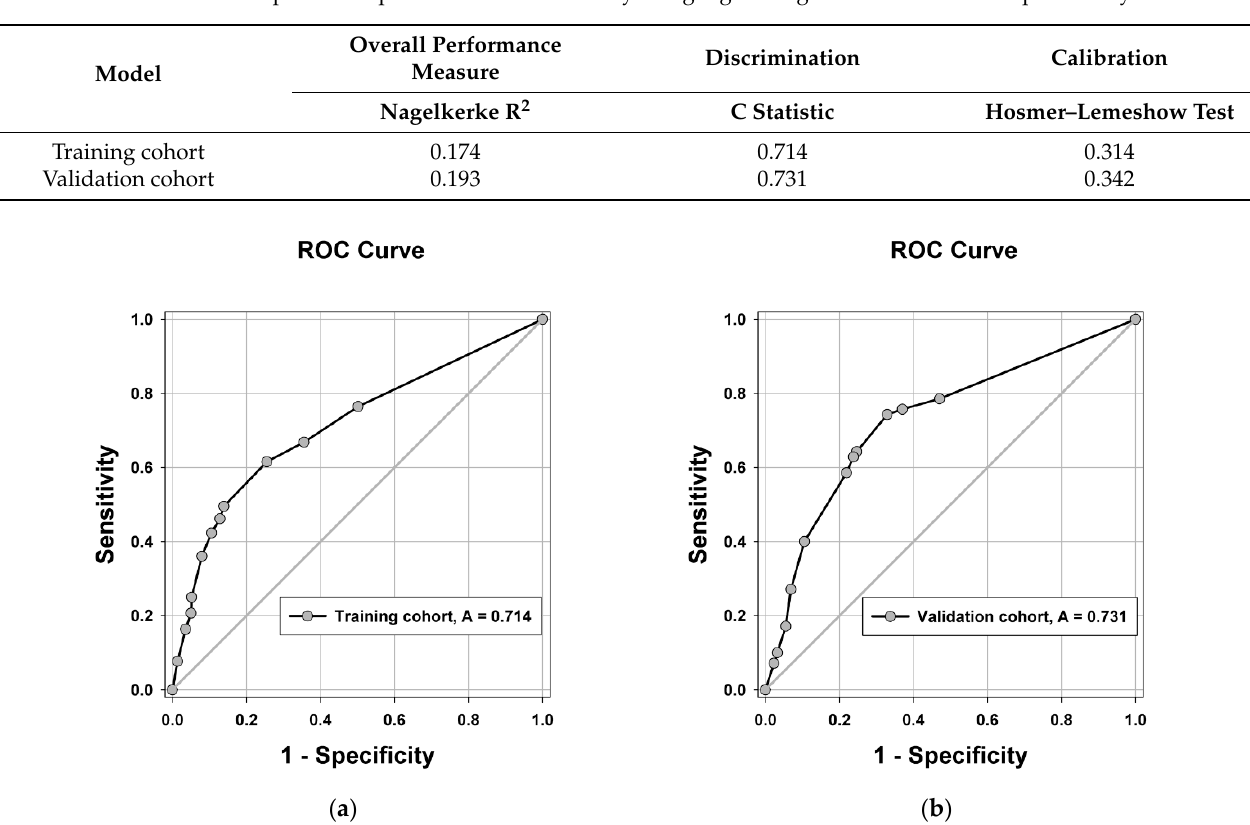
Table 3. Risk score model for the prediction of microvascular invasion.